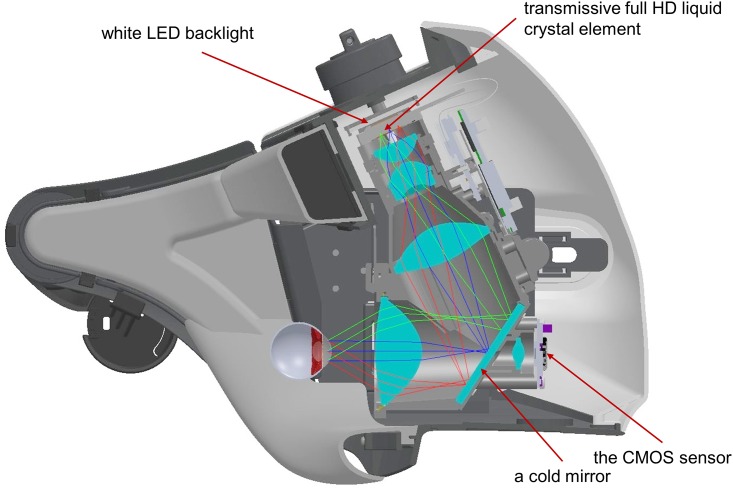
A cross-section image showing the structure of the perimeter unit.A test target is displayed on the full HD transmissive liquid crystal displays with high intensity LED backlights for the two eyes. Both pupils are illuminated by near infrared LEDs and these images are monitored by the SXVGA resolution CMOS image sensor.